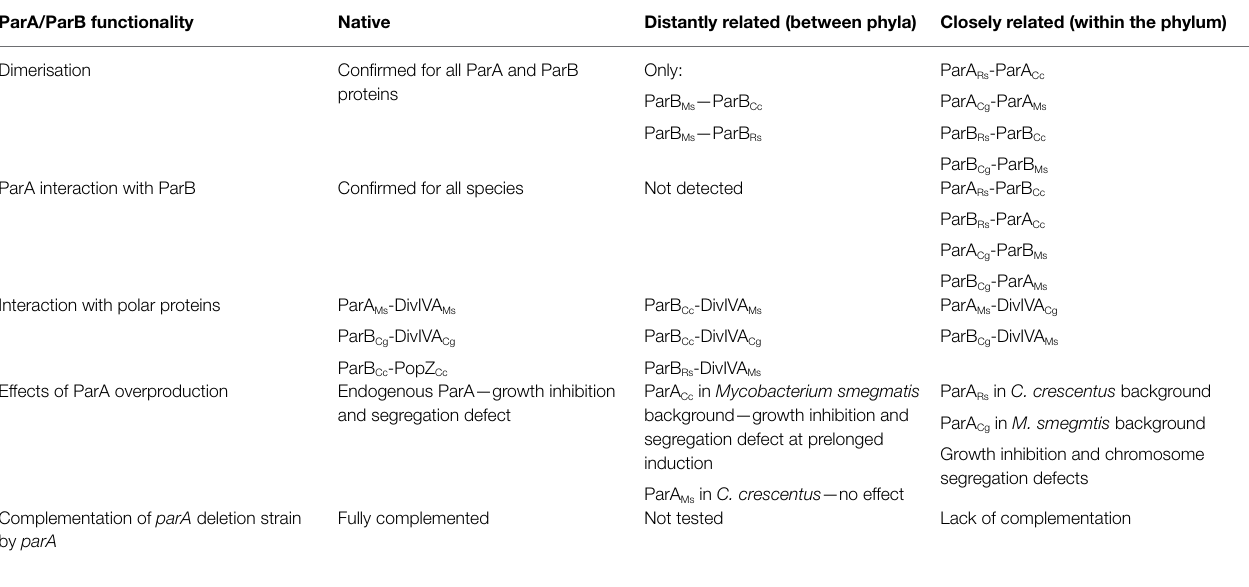
TABLE 1 | Summary of ParA and ParB proteins functionality in native and heterologous environment. ParA/ParB